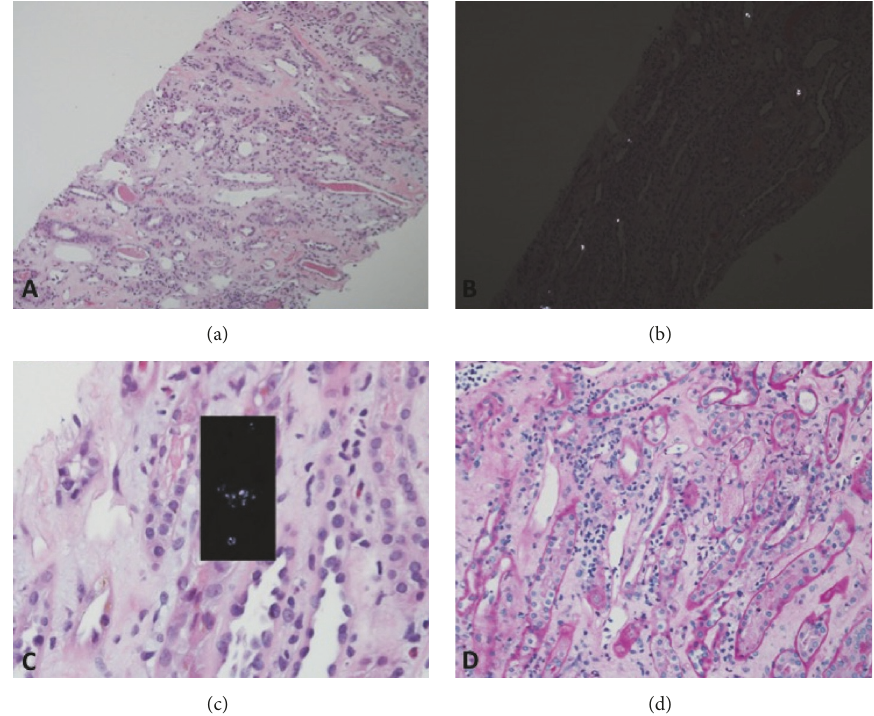
Figure 2: (a) H+E stain revealing residual acute tubular injury with focal epithelial necrosis and associated mild peritubular capillaritis and interstitial nephritis; (b) H+E stain showing polarizable oxalate crystals in several tubules; (c) H&E stain revealing acute tubular necrosis and oxalate crystals in the tubules; (d) PAS stain showing dilated peritubular capillaries with capillaritis and active interstitial